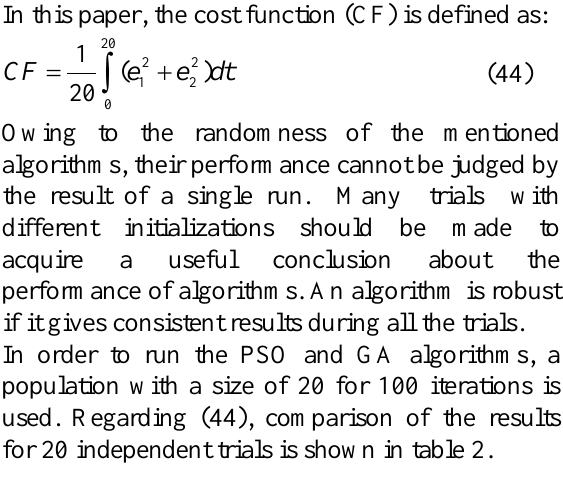
Table 2. Comparison of optimized PID